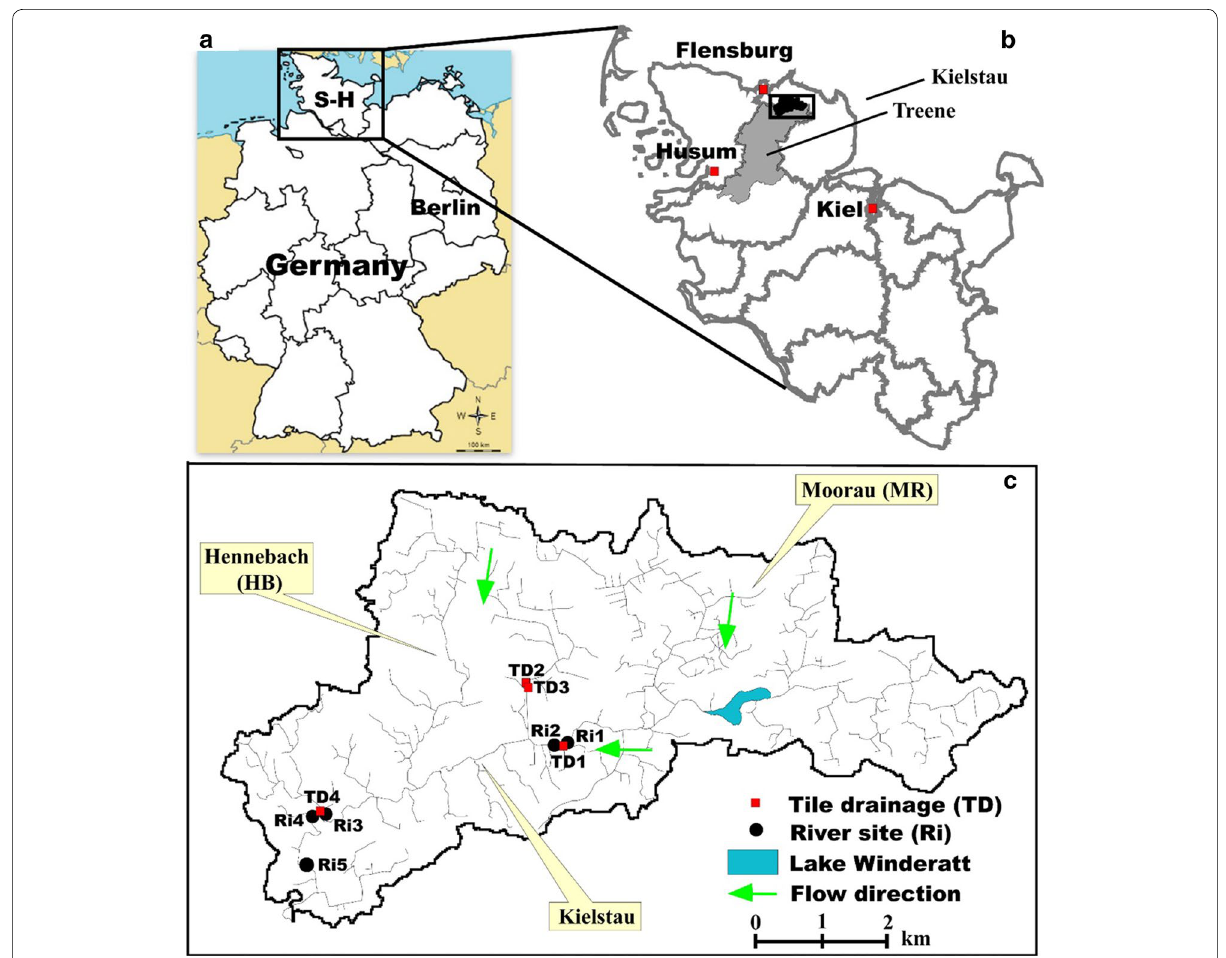
Fig. 1 The location of sampling sites in Kielstau catchment ( c ), Schleswig–Holstein state ( b ), Northern Germany ( a ). S–H